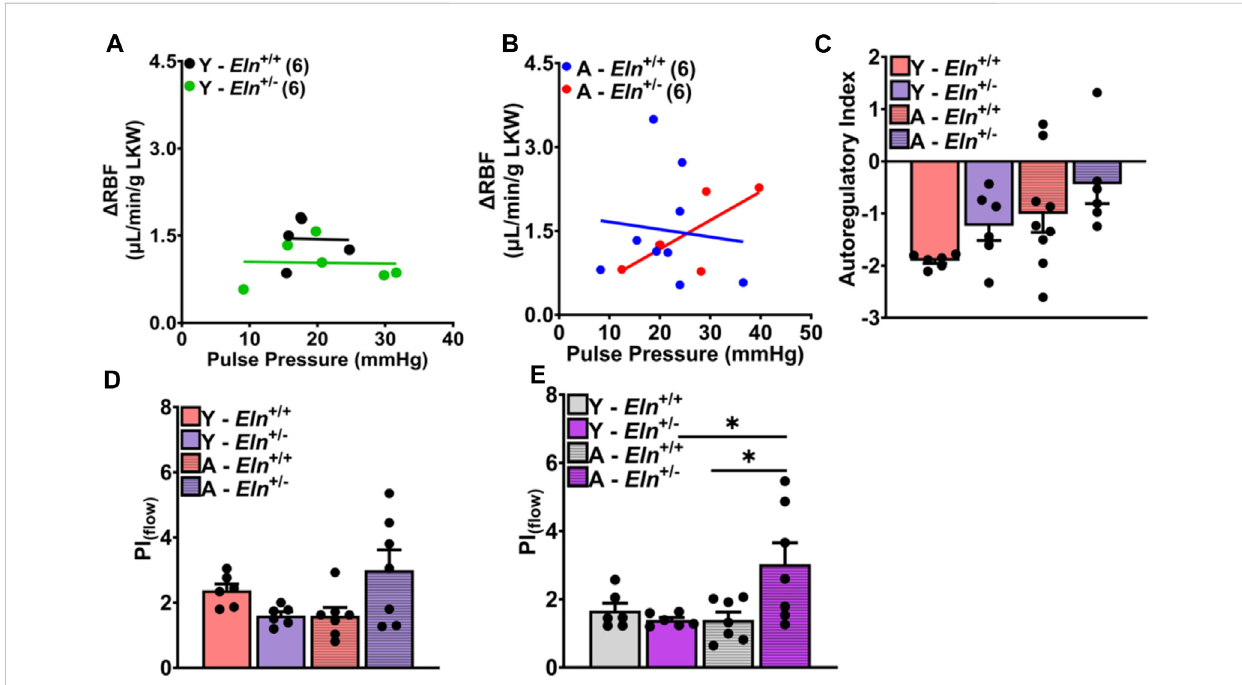
FIGURE 7 Effect of elastin insuf fi ciency and aging on the relationship between pulse pressure and RBF and on renal autoregulatory index in young and aged Eln +/+ and Eln +/ − mice. Scatterplot showing the correlation between RBF and pulse pressure in young (A) and aged (B) Eln +/+ and Eln +/ − mice at baseline. The correlation was examined using Pearson correlation analysis with a two-tailed test; N = 5-9 animals. (C) Calculated autoregulation index (AI) , where RBF1 and MAP1 are the average baseline values taken after initiating continuous determined using the following equation: AI (cid:1) [ ( RBF 2 − RBF 1 ) RBF 1 ] [ ( MAP 2 − MAP 1 ) MAP 1 ] infusion of cocktail and 10s before a step increase in systemic pressure by manual simultaneous occlusion of the celiac and superior mesenteric arteries, and RBF2 and MAP2 are the average values at approximately 2 min after the step increase in renal perfusion pressure. (D) Baseline pulsatility index (PI fl ow ) ,whereRBF max ismaximumrenalblood fl ow,RBF min and (E) PI fl ow afterocclusion,calculatedusingthefollowingequation PI flow (cid:1) RBF max − RBF min RBF mean